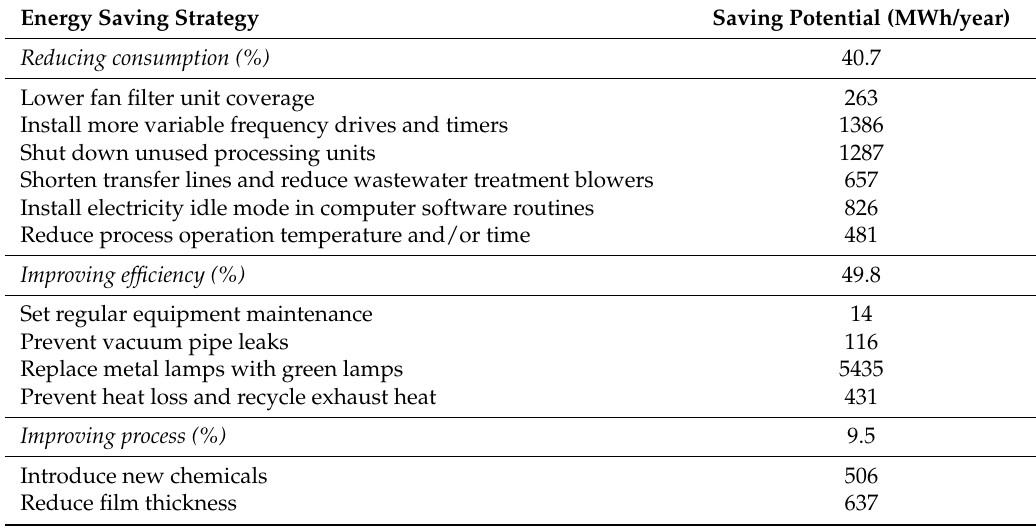
Table 3. Saving potential of energy conservation